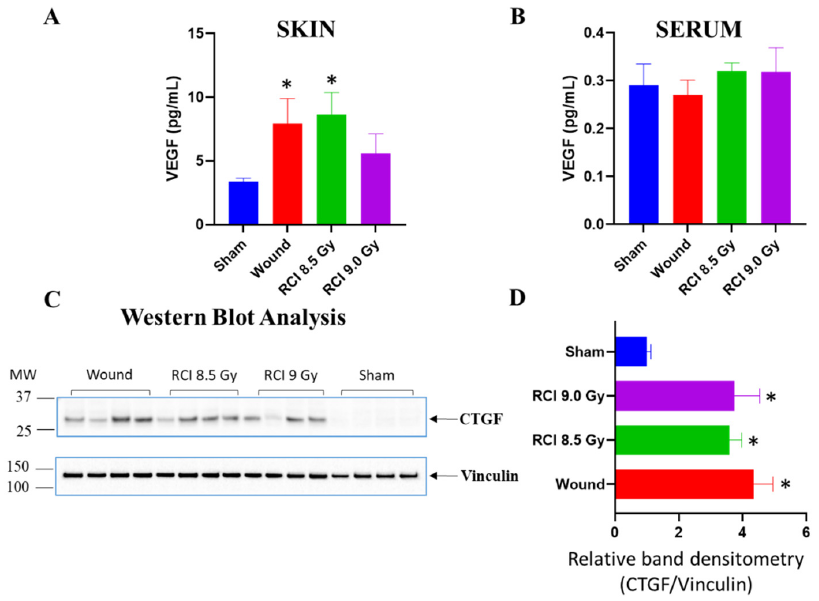
Figure 6. Both 8.5 Gy RCI and SW alone significantly upregulate VEGF expression in skin wounds on day 30, and no significant differences are observed between sham and 9.0 Gy RCI ( A ). ( B ) There were no differences in serum VEGF levels in all groups. ( C ) Western blot analysis of CTGF expres- sion in skin wounds, and their band densitometry analysis as shown in ( D ). CTGF (connective tissue growth factor) expression was upregulated in wound and RCI groups. * p < 0.05 for wound vs. sham, RCI 8.5 Gy vs. sham, and RCI 9.0 Gy vs. sham by Mann–Whitney Test (unpaired, two-tailed); N = 4. MW: molecular